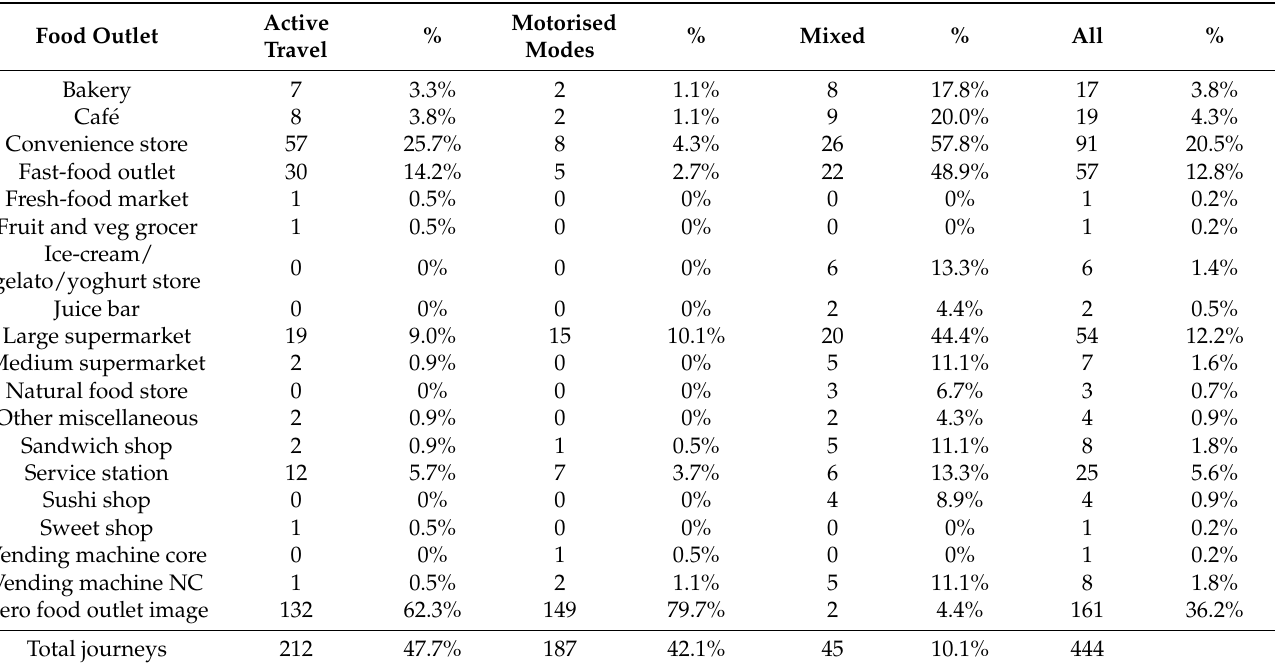
Table 2. Number of journeys in which there was exposure to one or more food outlet type by travel